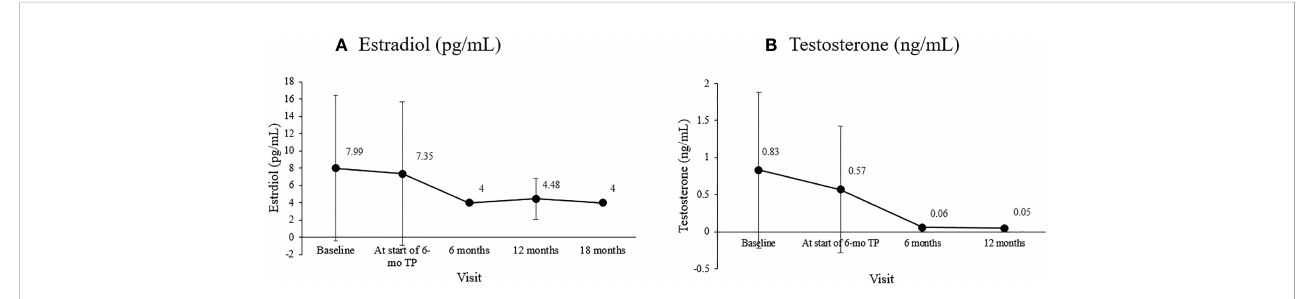
FIGURE 1 Changes in the mean sex hormone levels during treatment. (A) Estradiol (pg/mL; overall P =0.006). (B) Testosterone (ng/mL; overall p = 0.040)